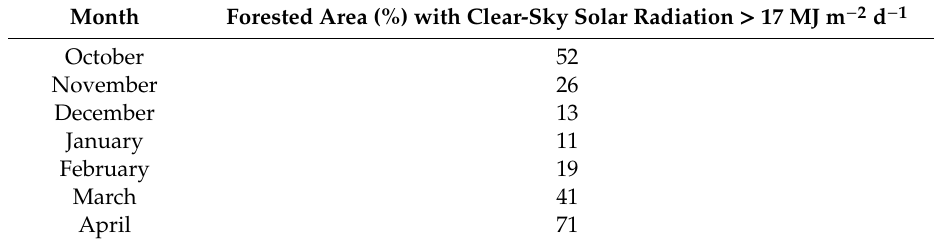
Table 5. Fraction of the forested area matching the required solar illumination level, i.e., clear-sky